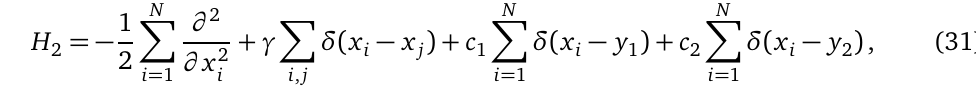
Figure 6: Illustration of a system of N bosons and two static impurities confined to a ring of length L . The i th boson has the coordinate x → ∞ ) is placed at y ( c 1 = d y 2